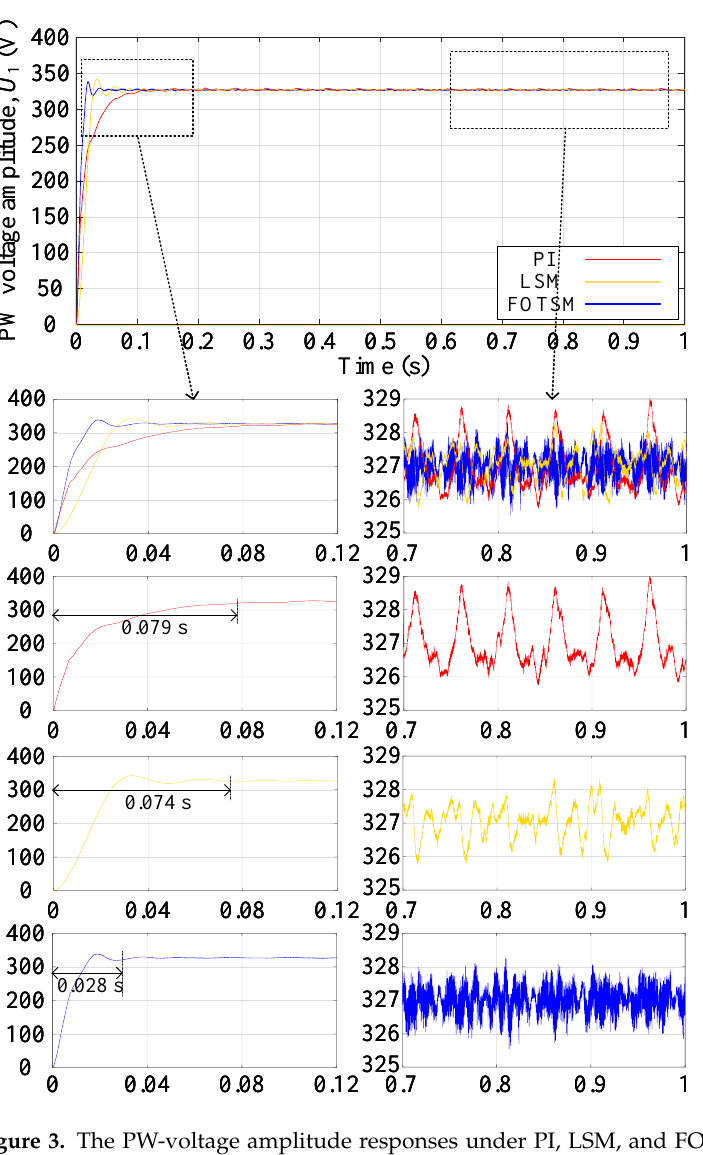
Figure 3. The PW-voltage amplitude responses under PI, LSM, and FOTSM during the start-up process.